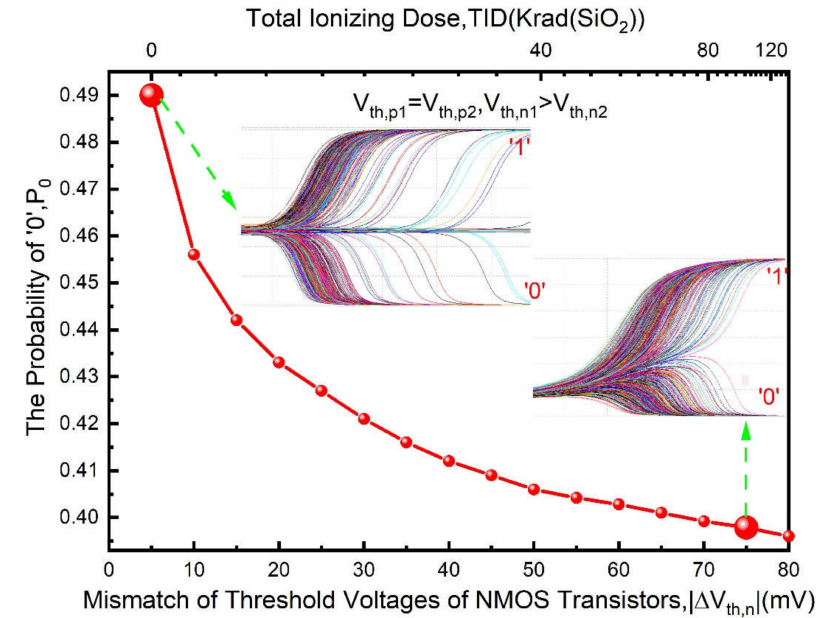
Figure 8. Simulation results for a weak cell ( V th , n 1 > V th , n 2 ), its initialized value faintly tends to